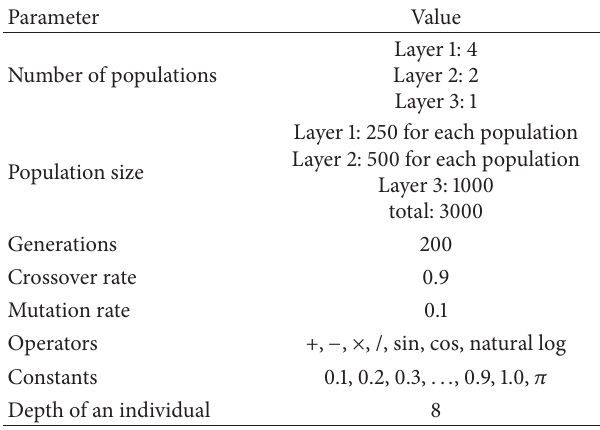
Table 3: Genetic programming parameters.